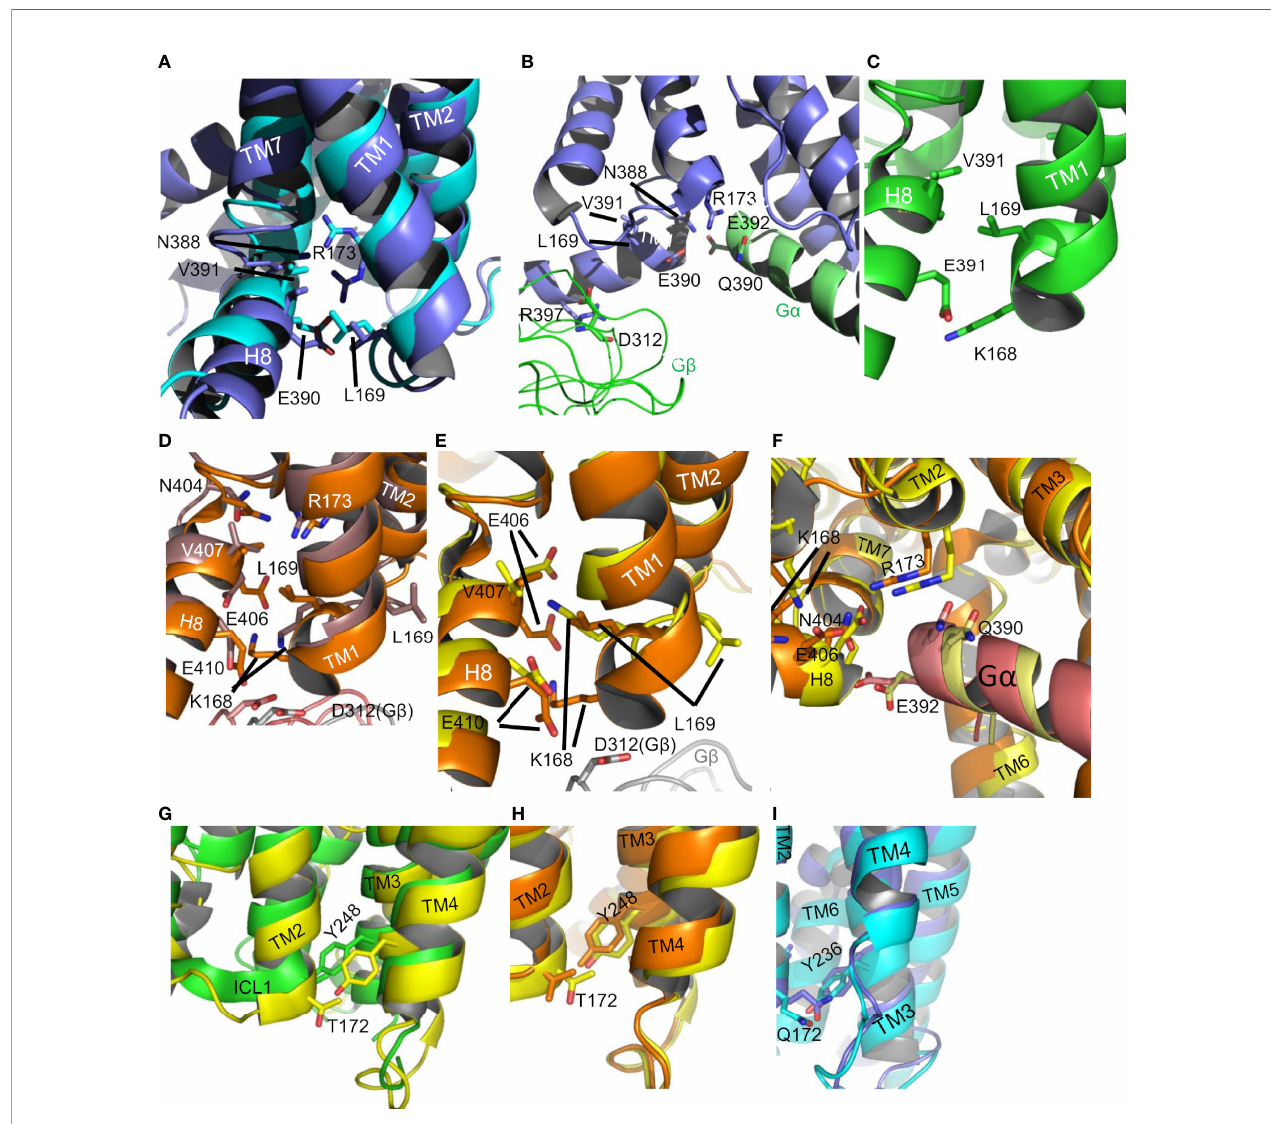
FIGURE 9 | The ICL1-H8 interface in CGRP. (A) The interface (6E3Y, active, slate; 7KNT inactive, cyan). (B) Contacts of the active CGRP (6E3Y, active, slate) receptor with G a s (cartoon helix, green) and G b (ribbon, green). (C) The ICL1-H8 interface in GCGR (5EE7 inactive, green). (D) The ICL1-H8 interface in GCGR ((6WPW active G a s, orange/6LML active G a i, brown)). In the inactive crystal structures 4L6R, 5YQZ, 5XEZ and the G protein bound cryo-em structures 6WHC, 6LMK, and 6LML, there is a rotation in the middle of the ICL1 so that L 12.50 points upwards between TM1 and TM2 and K 12.49 points to H8. E 8.49 and E 8.53 can interact with the side chain of K 12.49 , perhaps helping to keep H8 engaged with ICL1. In the inverse-agonist stabilised crystal structure 5EEZ and the G a s-bound cryo-em 6WPW, L 12.50 points to H8 and K 12.49 is beneath the receptor. D312 of G b is close to IL1 in both structures. (E) The ICL1-H8 interface in GCGR (6WPW active Gs, orange/6WHC active G a s, yellow). The variation of the K168 orientation is indicative of water mediated interactions. (F) G a s contacts in GCGR for 6WPW active, orange and 6WHC active, yellow. (G) The ICL1-ICL2 interface in the GCGR (5EE7 inactive). (H) The ICL1-ICL2 interface in the GCGR (6WPW active G a s, green/6WHC active Gi, orange). (I) The ICL1-ICL2 interface in the CGRP (6E3Y, active,